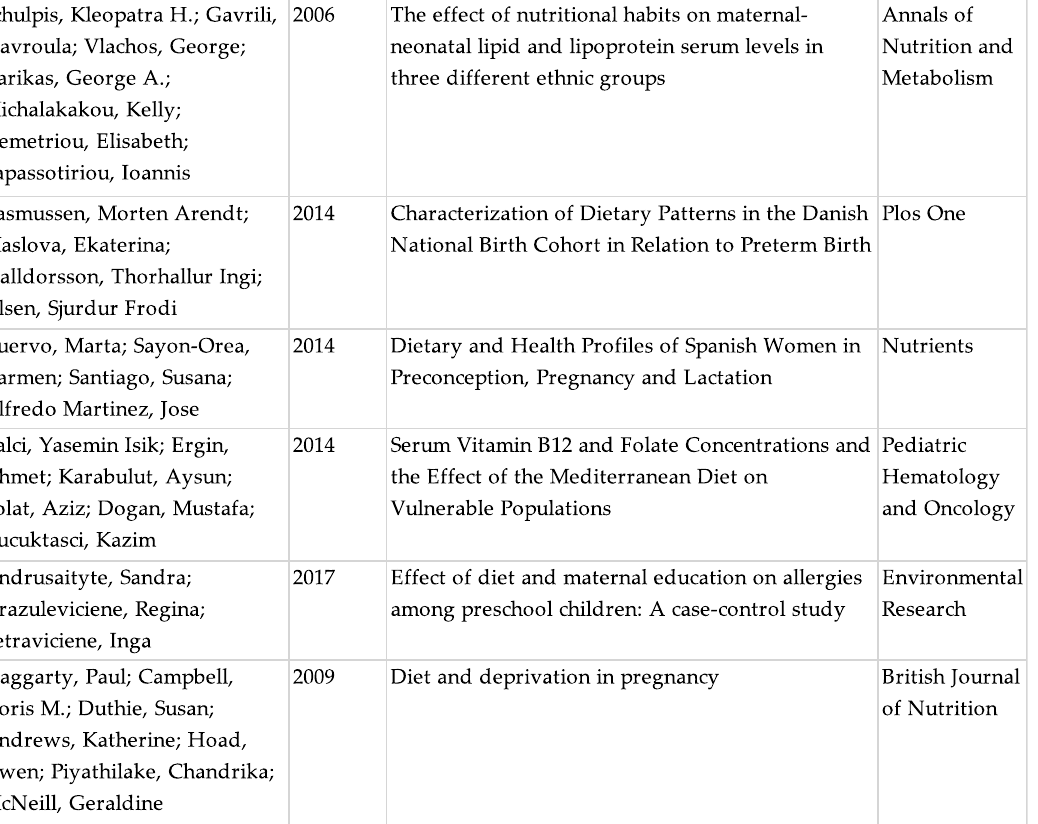
Figure A1. The papers excluded after full-text screening.